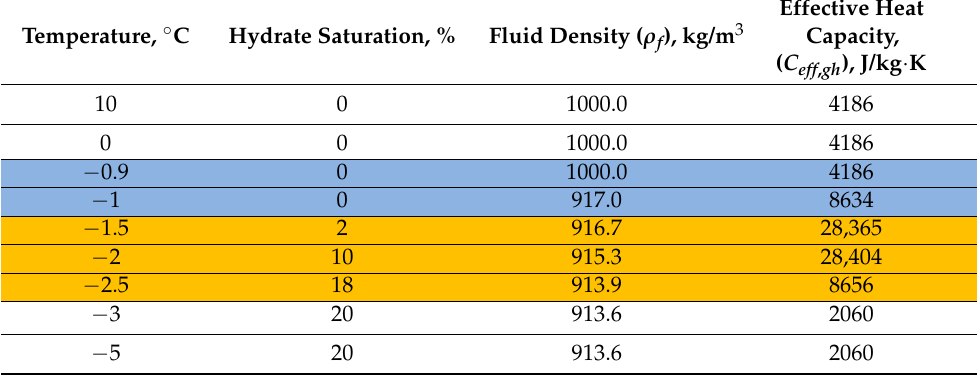
Table 4. Thermal properties of lean clay containing 20% of pore gas hydrates (depth interval 60–120 m), with regard to the phase state of pore moisture and temperature. Temperature, ◦ C Hydrate Saturation, % Fluid Density ( ρ f ), kg/m 3